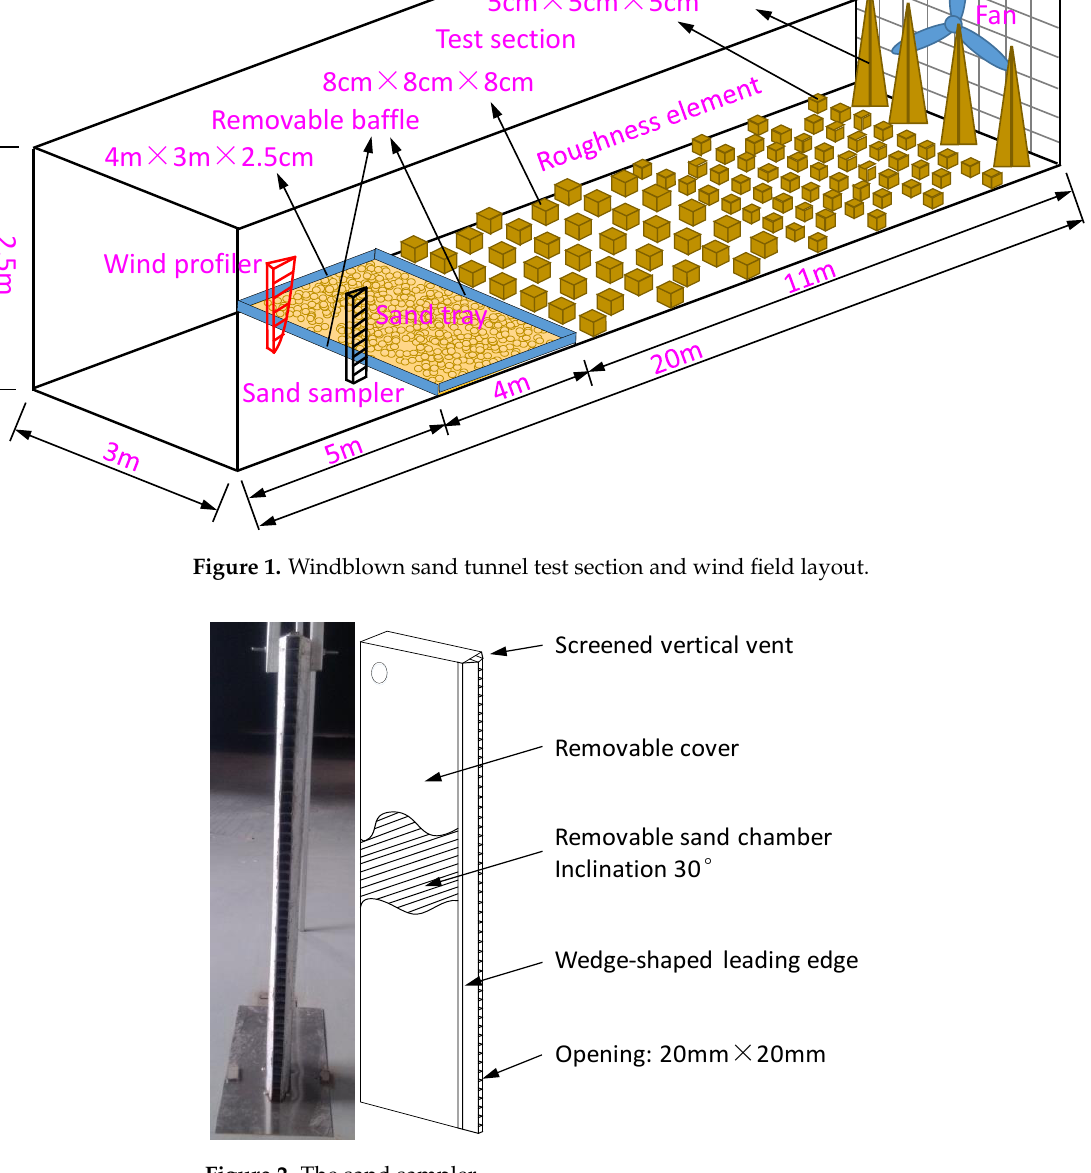
Figure 3. The wind profiler. Sand samples are taken from Tengger Desert with a particle size of no more than 1.0 mm [46]. The particle size of the fine sand, coarse sand and mixed sand obtained through the screening instrument is 0–0.5 mm, 0.5–1.0 mm and 0–1.0 mm, respectively. The volume ratio of coarse sand to fine sand in mixed sand is approximately 1:3. The sand sampler is about 15 m away from the entrance to the test section and 5 cm away from the upwind sand tray. The bottom plate of the lowest sand inlet is flat with the wind tunnel floor. The sand bed device assembled by the sand trays is 4 m in length, 3 m in width and 2.5 cm in depth, which could ensure the full development of the saltation movement [34,40]. Before testing, put the sand samples into the sand trays and make their surface flat; and cover a piece of geo-textile on the sand trays before the preset wind speed is reached, so that the sand samples would not be blown away. When the wind speed reaches the preset value, remove the geo-textile and baffles of the sand trays to carry out the windblown sand test. If sand samples of approximately 2 cm depth in the sand trays are blown away, the sand samples must be refilled to reduce measurement errors. Based on the actual conditions in desert regions, it is sufficient to describe the full development of particle movement and the characteristics of sand transport by simulating